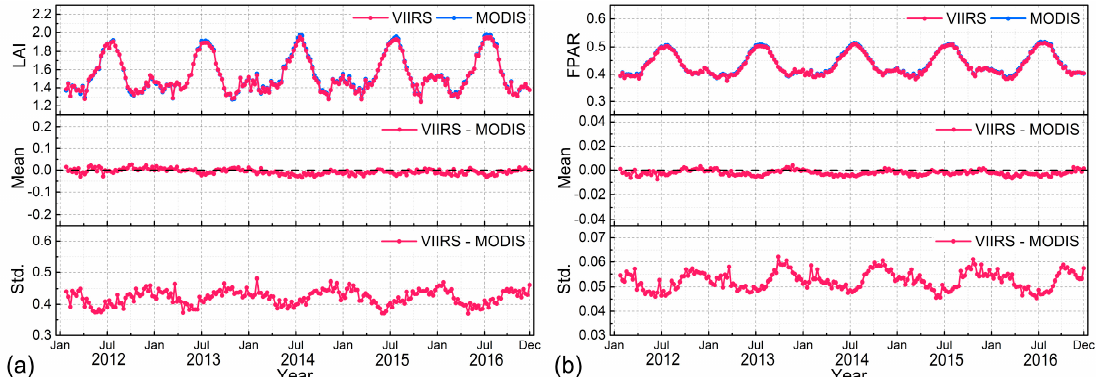
Figure 1. The global mean ( a ) LAI and ( b ) FPAR of VIIRS and MODIS at 8-day interval during 2012–2016. The top panels of ( a , b ) show the seasonal variation of VIIRS and MODIS LAI/FPAR retrievals, while the bottom two panels show the mean and standard deviation (std.) of difference (the difference was first calculated in each 10 km × 10 km grid, and then the mean and std. were calculated for all grids) between the two products (VIIRS-MODIS). The mean difference indicates whether VIIRS and MODIS products have systematic errors, while the std. of difference shows the dispersion of errors between VIIRS and MODIS products. Also see Figure S4 for the evaluation between VIIRS and MODIS LAI/FPAR products at the native spatial resolution (500-m) for each biome.